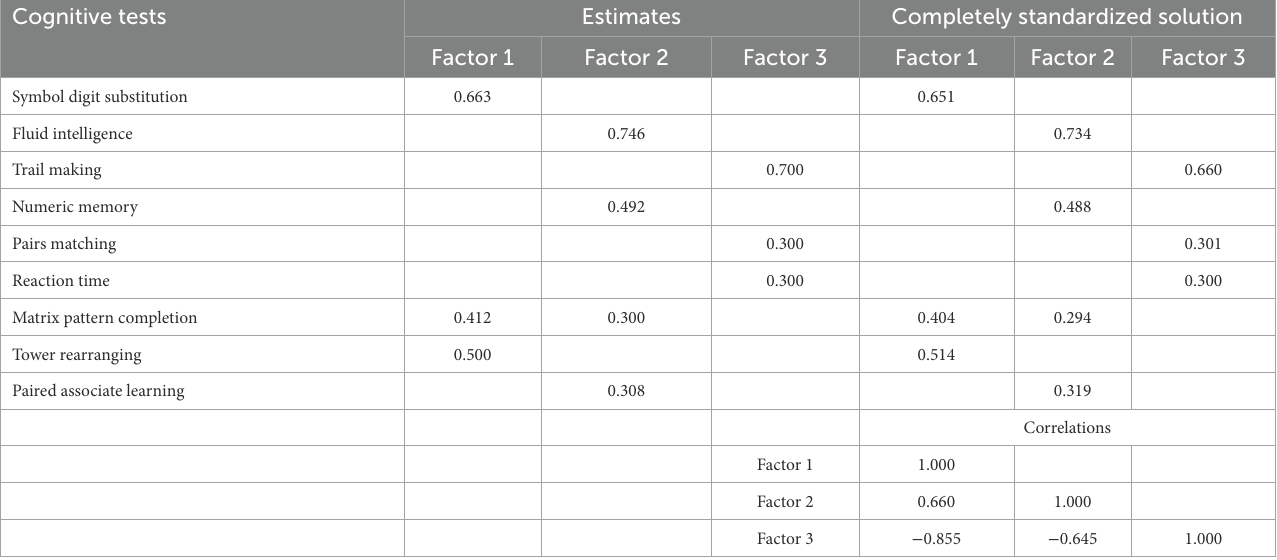
TABLE 4 A three-factors model of cognitive tests based on ESEM analysis. Cognitive